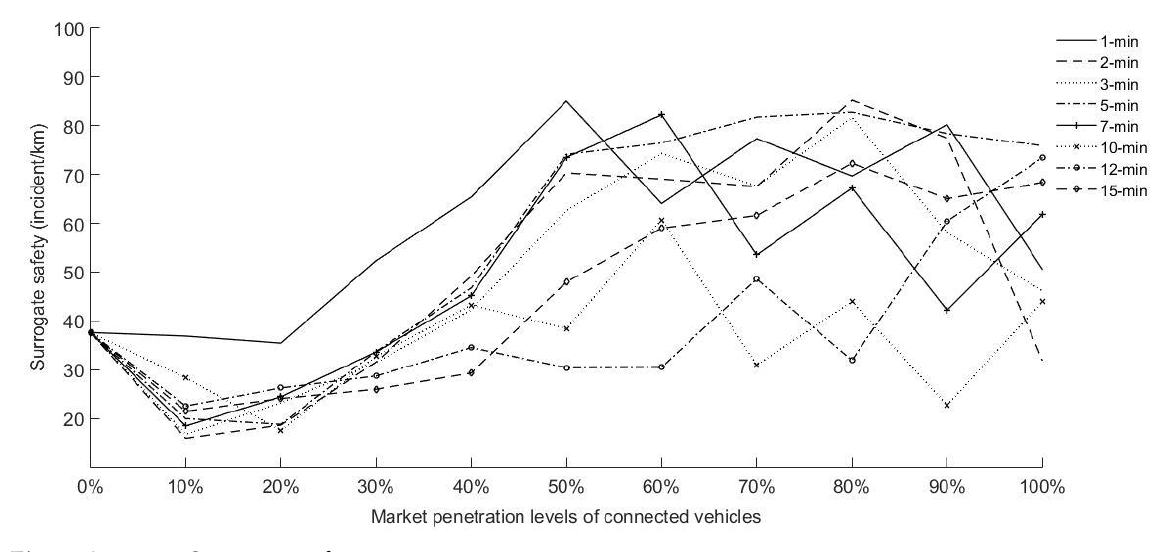
Surrogate safety